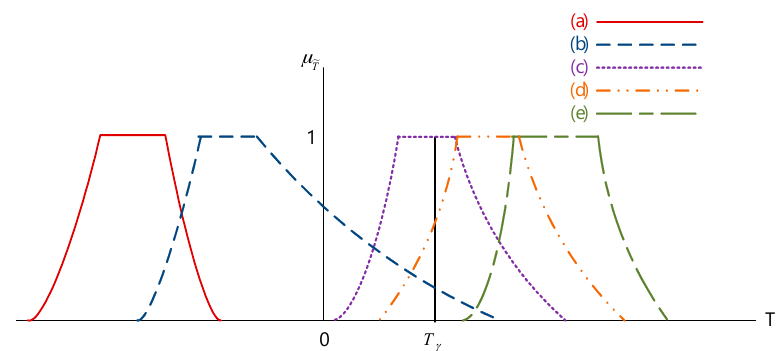
~ for the right-sided test.